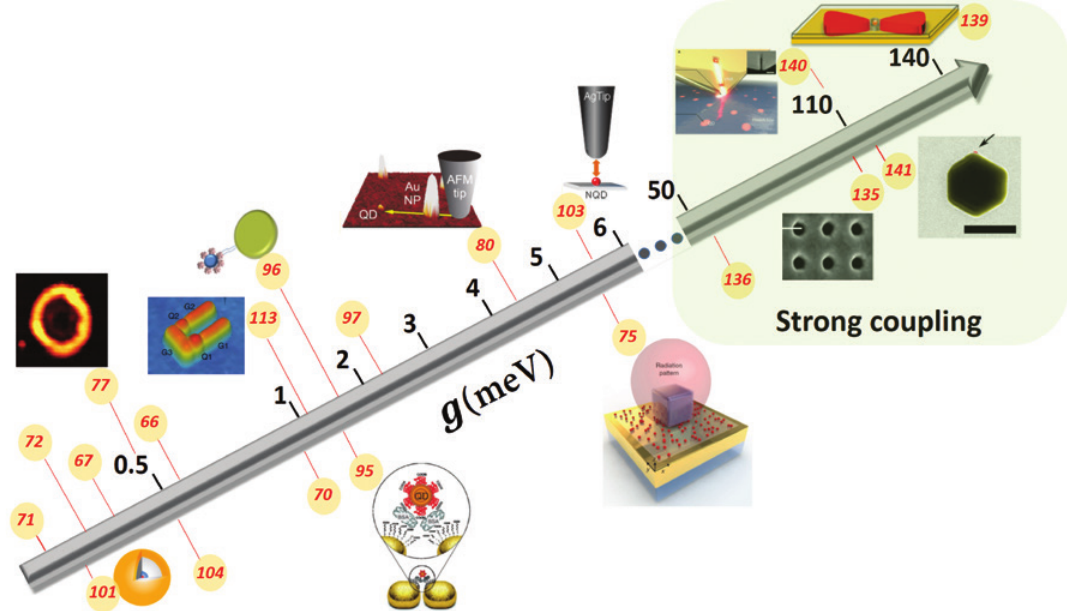
Figure 6: From weak to strong